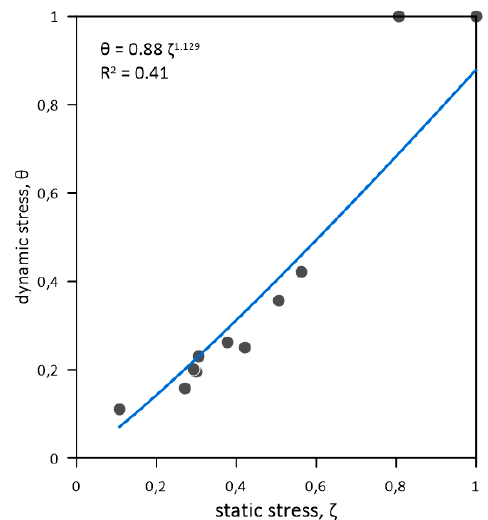
Figure 6. Dynamic versus static stress.